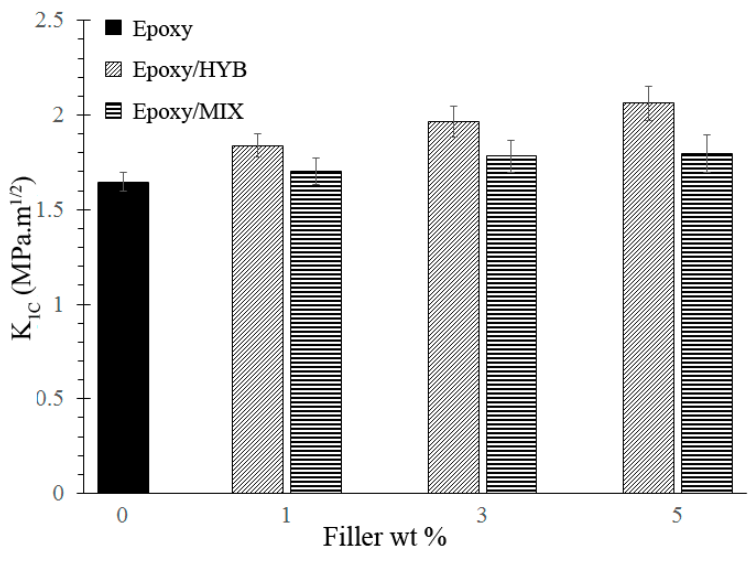
Figure 4. Stress intensity factor ( K 1 C ) of the neat epoxy and the epoxy composites with 1 wt %, 3 wt %, and 5 wt % of HYB and MIX.